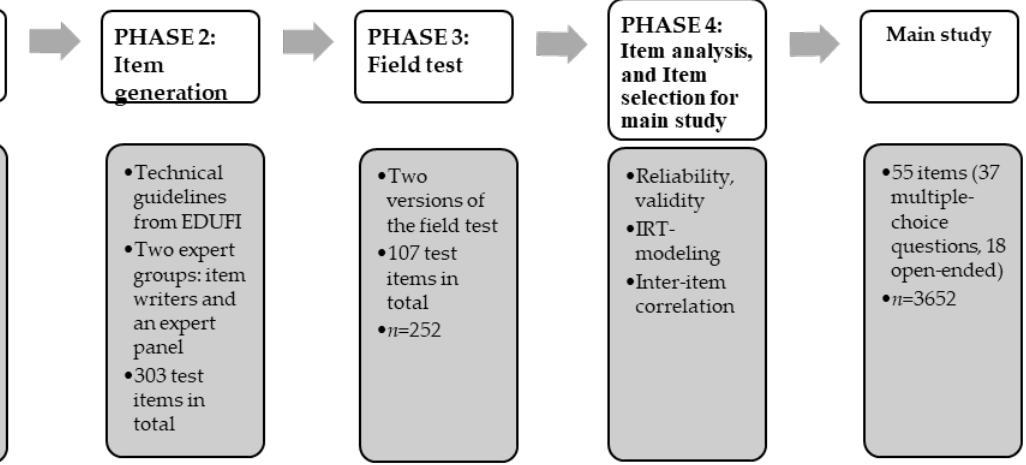
Figure 1. The phases in developing an HL measurement instrument for school-aged children (aged 15 – 16).